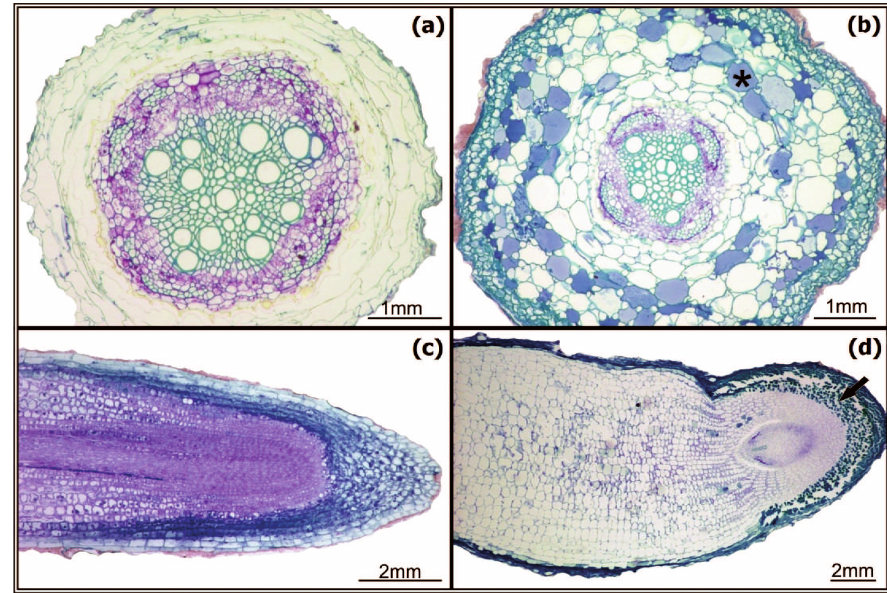
Figure 2. Main root structure of Acacia mangium (a and b; transverse cut) and root apex structure of Mimosa caesalpiniaefolia (c and d; longitudinal cut) after 60 d growing on a clayey substrate. A and C: Control treatment. B and D: treatment with 400 mg kg -1 As. * Phenolic compound accumulation in cortical parenchyma cells. Arrow: Dead cells near the root